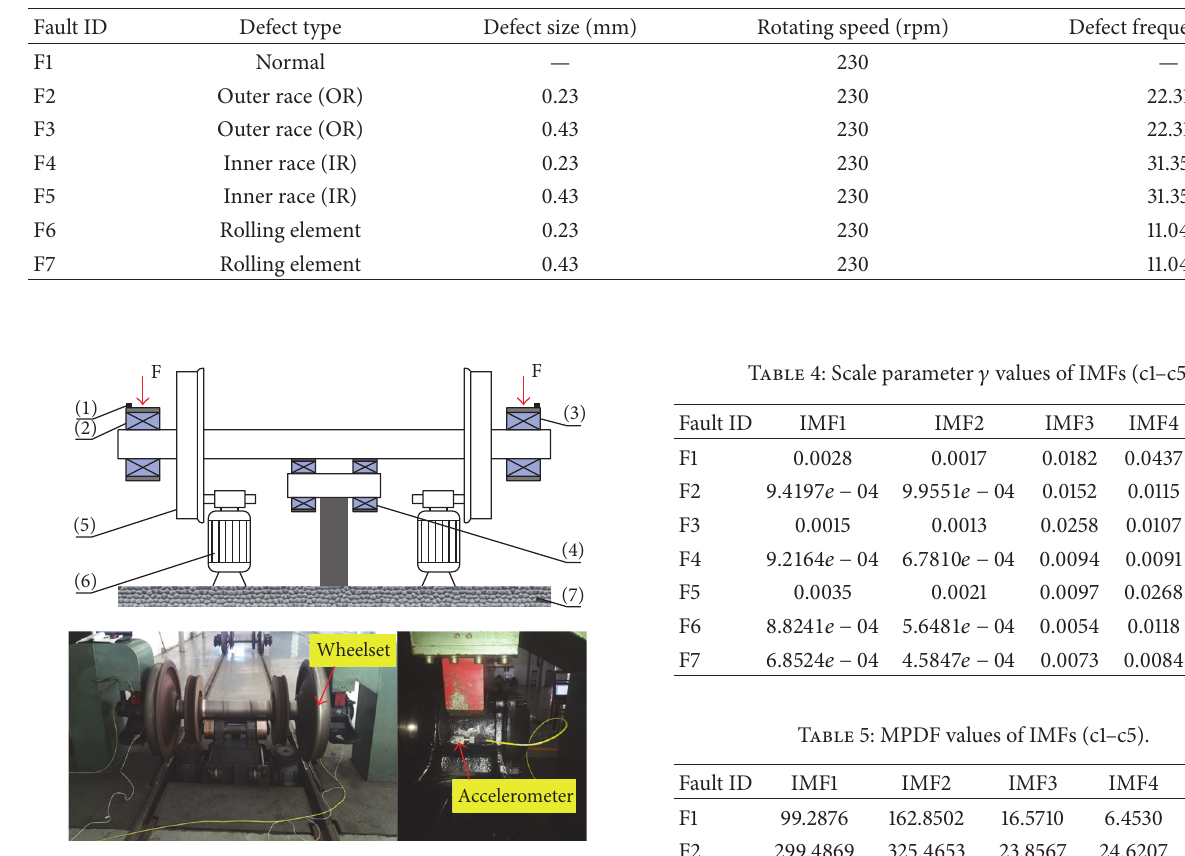
Table 2: Specifications of the bearing defects.